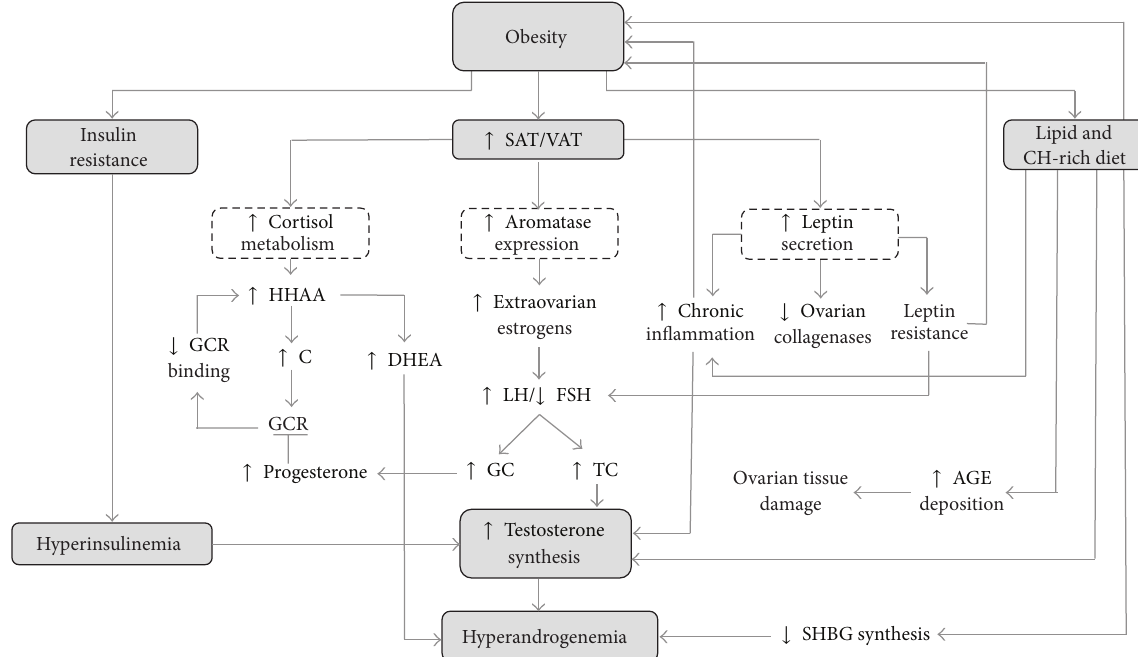
Figure 3: Mechanisms for obesity-mediated potentiation of hyperandrogenemia in polycystic ovary syndrome. SAT = subcutaneous adipose tissue; VAT = visceral adipose tissue; HHAA = hypothalamus-hypophysis-adrenal-axis; C = cortisol; GCR = glucocorticoid receptor; DHEA = dehydroepiandrosterone; LH = luteinizing hormone; FSH = follicle-stimulating hormone; GC = granulosa cells; TC = teca cells; Ch = carbohydrate; AGE = advanced glycation end products; SHBG = sex hormone binding globulin. In PCOS, obesity may potentiate hyperandrogenemia through several mechanisms. Aside from hyperinsulinemia-mediated effects of IR, increased adiposity leads to faster cortisol metabolism, which results in hyperactivation of the HHAA and thus increased DHEA synthesis. Competitive binding to GCR by GC-produced progesterone derives into diminished cortisol binding to GCR, reinforcing HHAA activation. High adiposity also leads to greater aromatase expression in adipocytes, which allows for increased extraovarian estrogen synthesis. In turn, this causes an elevated LH/FSH ratio, prompting hyperplasia of GC and TC, which then synthesizes greater amounts of progesterone and testosterone, respectively. Hyperleptinemia and leptin resistance result in alterations of LH secretion, as well as downregulation of ovarian collagenases, and promotion of a chronic inflammatory state. Carbohydrate-rich diets may induce oxidative stress in circulating mononuclear blood cells and thus chronic inflammation. Lipid-rich diets have been reported to increase testosterone synthesis and downregulate SHBG synthesis, resulting in hyperandrogenemia. These diets also favor endogenous and exogenous AGE deposition, which results in overall ovarian tissue